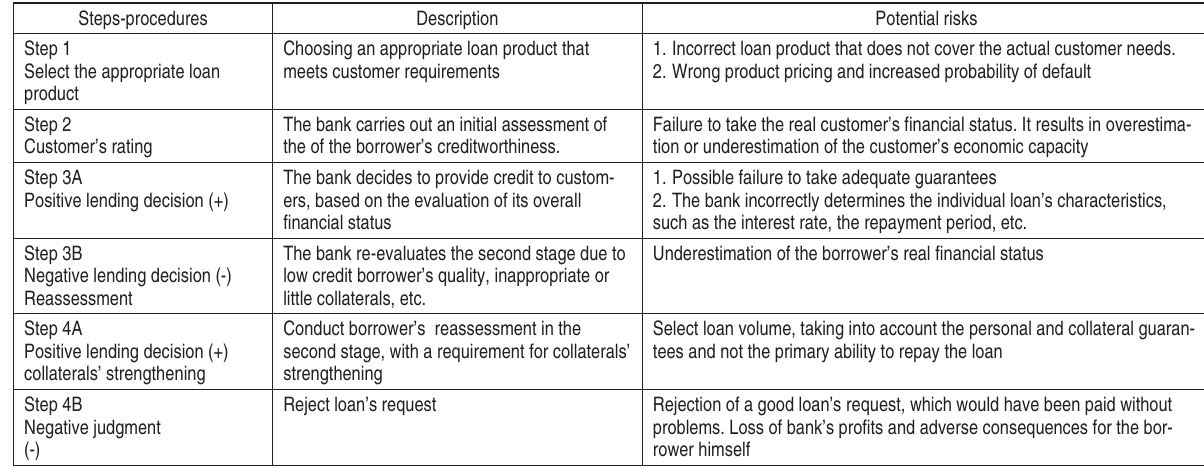
Table 1. Key steps in a bank’s loan